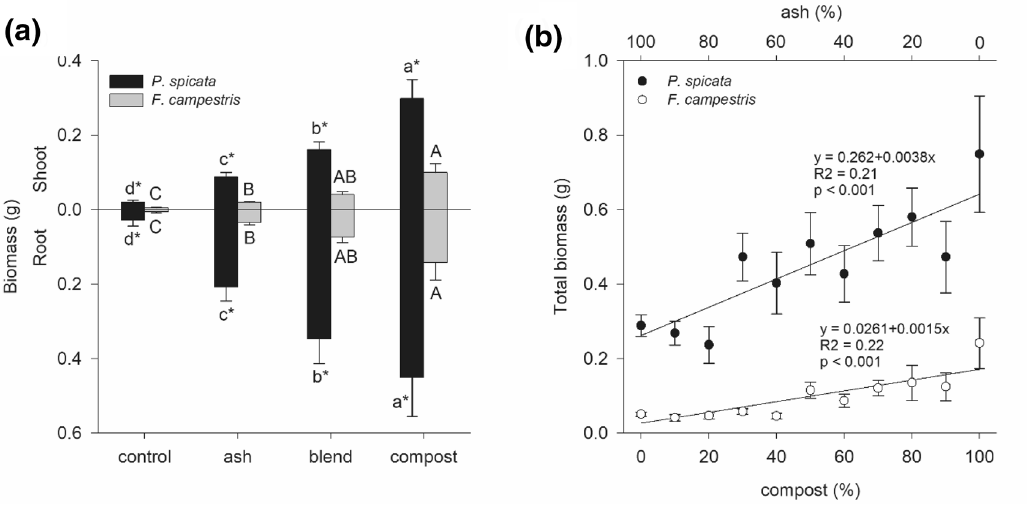
errors of the mean ( n = 10). Treatments with different letters are statistically significant within species (lower case = P. spicata ; upper case = F. campestris ) at P < 0.05 (one-way ANOVA, Tukey’s HSD). *Represents a statistical significance between species (determined by Welch’s t -test) for that